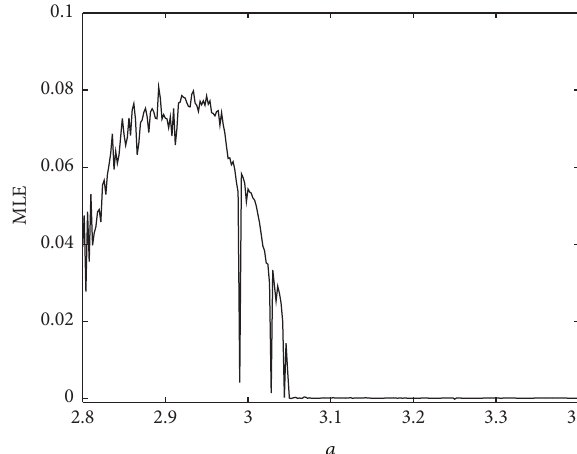
Figure 2: Bifurcation diagram of the system with infinite equilibria (1) when varying 𝑎 .